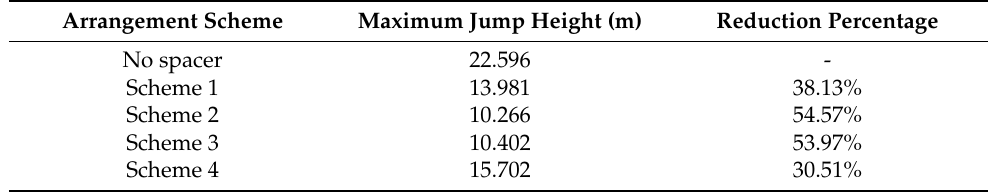
Table 5. Jump heights of ice-shedding conductors under different interphase spacer